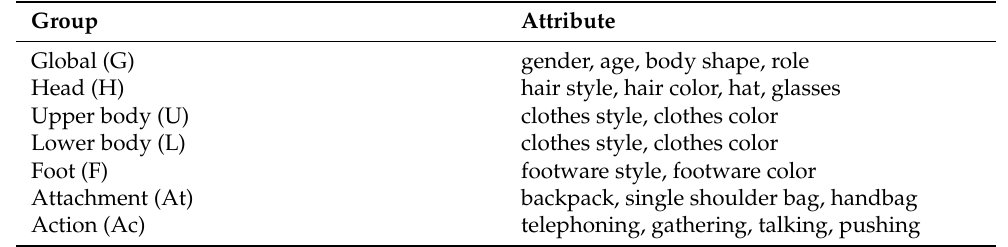
Table 3. Attribute categorization on RAP